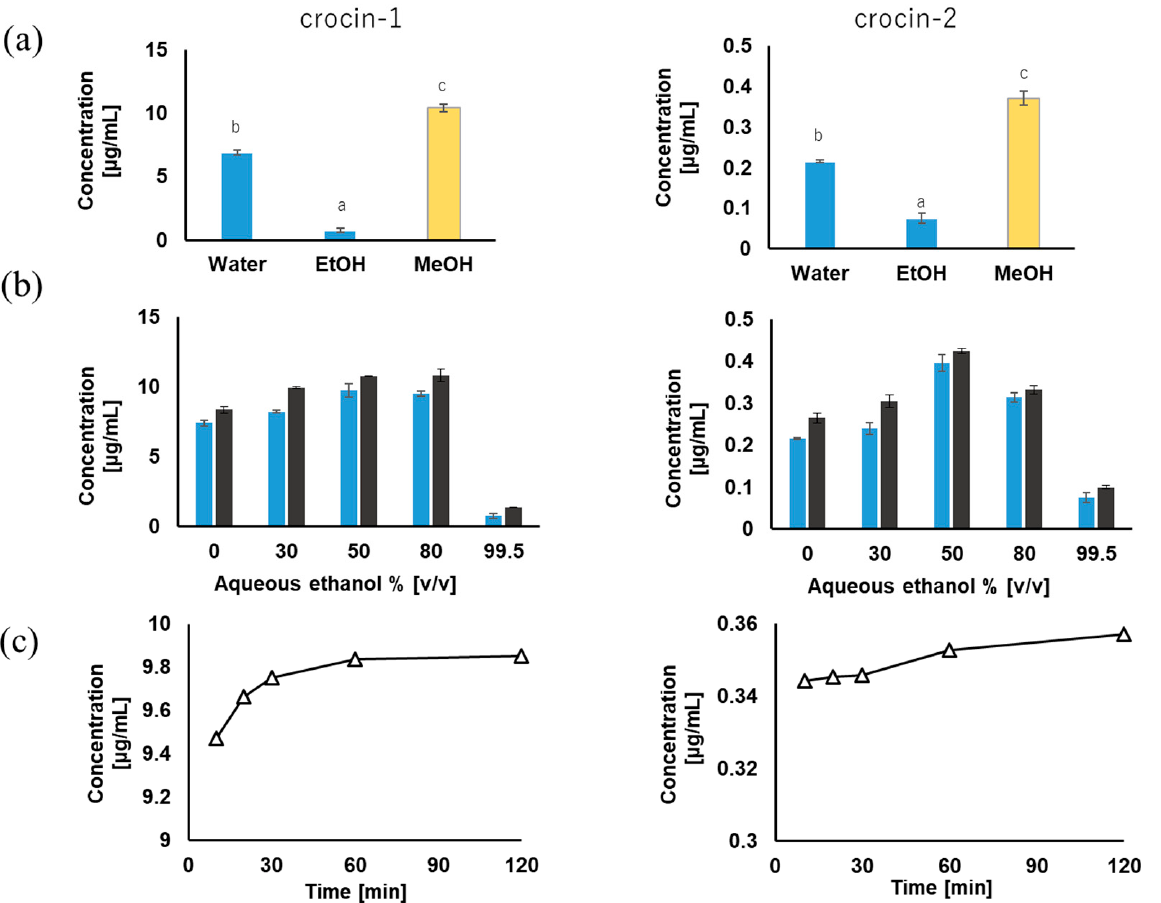
Figure 3. Extraction concentrations of crocin-1 and crocin-2 from gardenia fruit pulp using conventional solid–liquid extraction (SLE): ( a ) effect of different solvents on extraction concentration; ( b ) effect of ethanol concentration on extraction concentration at 25 °C under atmospheric pressure with ( ■ ) or without ( ■ ) direct sonication (125 s, 20% amplitude). Error bars represent means ± SE (n = 3). Letters on top of the columns represent significant differences among methods at the 0.05 level. ( c ) Effect of extraction time on extraction concentration of crocin-1 and crocin-2 in conventional SLE system using 80% ethanol at 25 °C under atmospheric pressure.